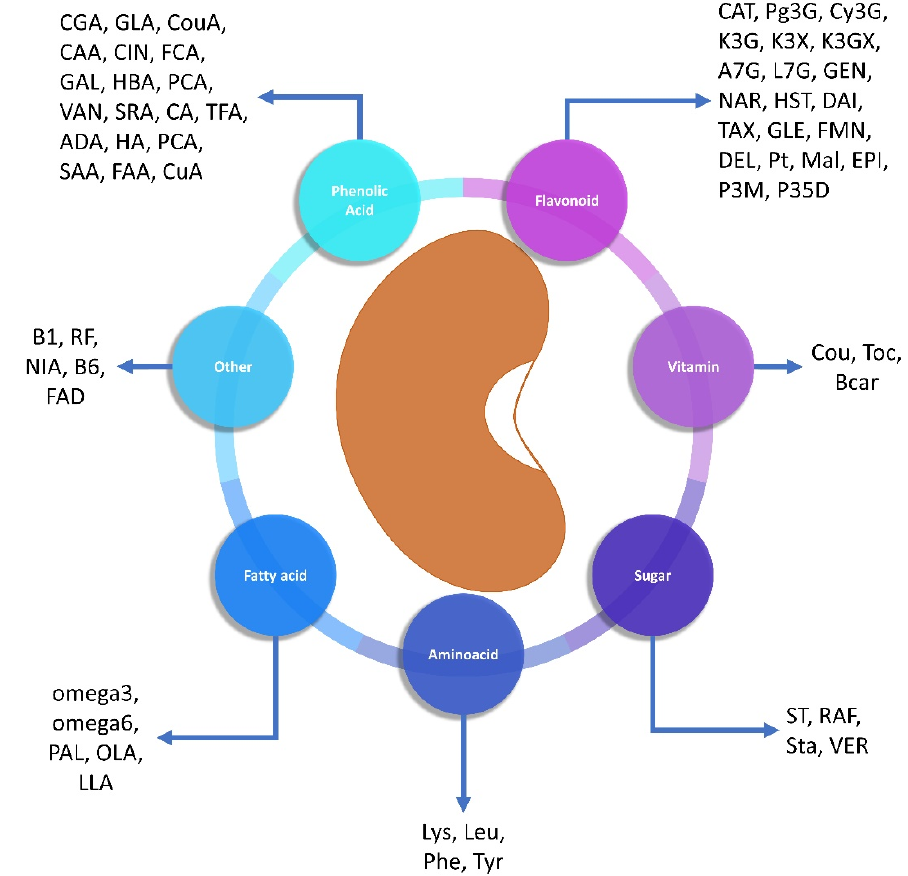
Figure 1. Compounds identified in Phaseolus vulgaris L. A7G: apigenin-7-glucoside [51], ADA: al-